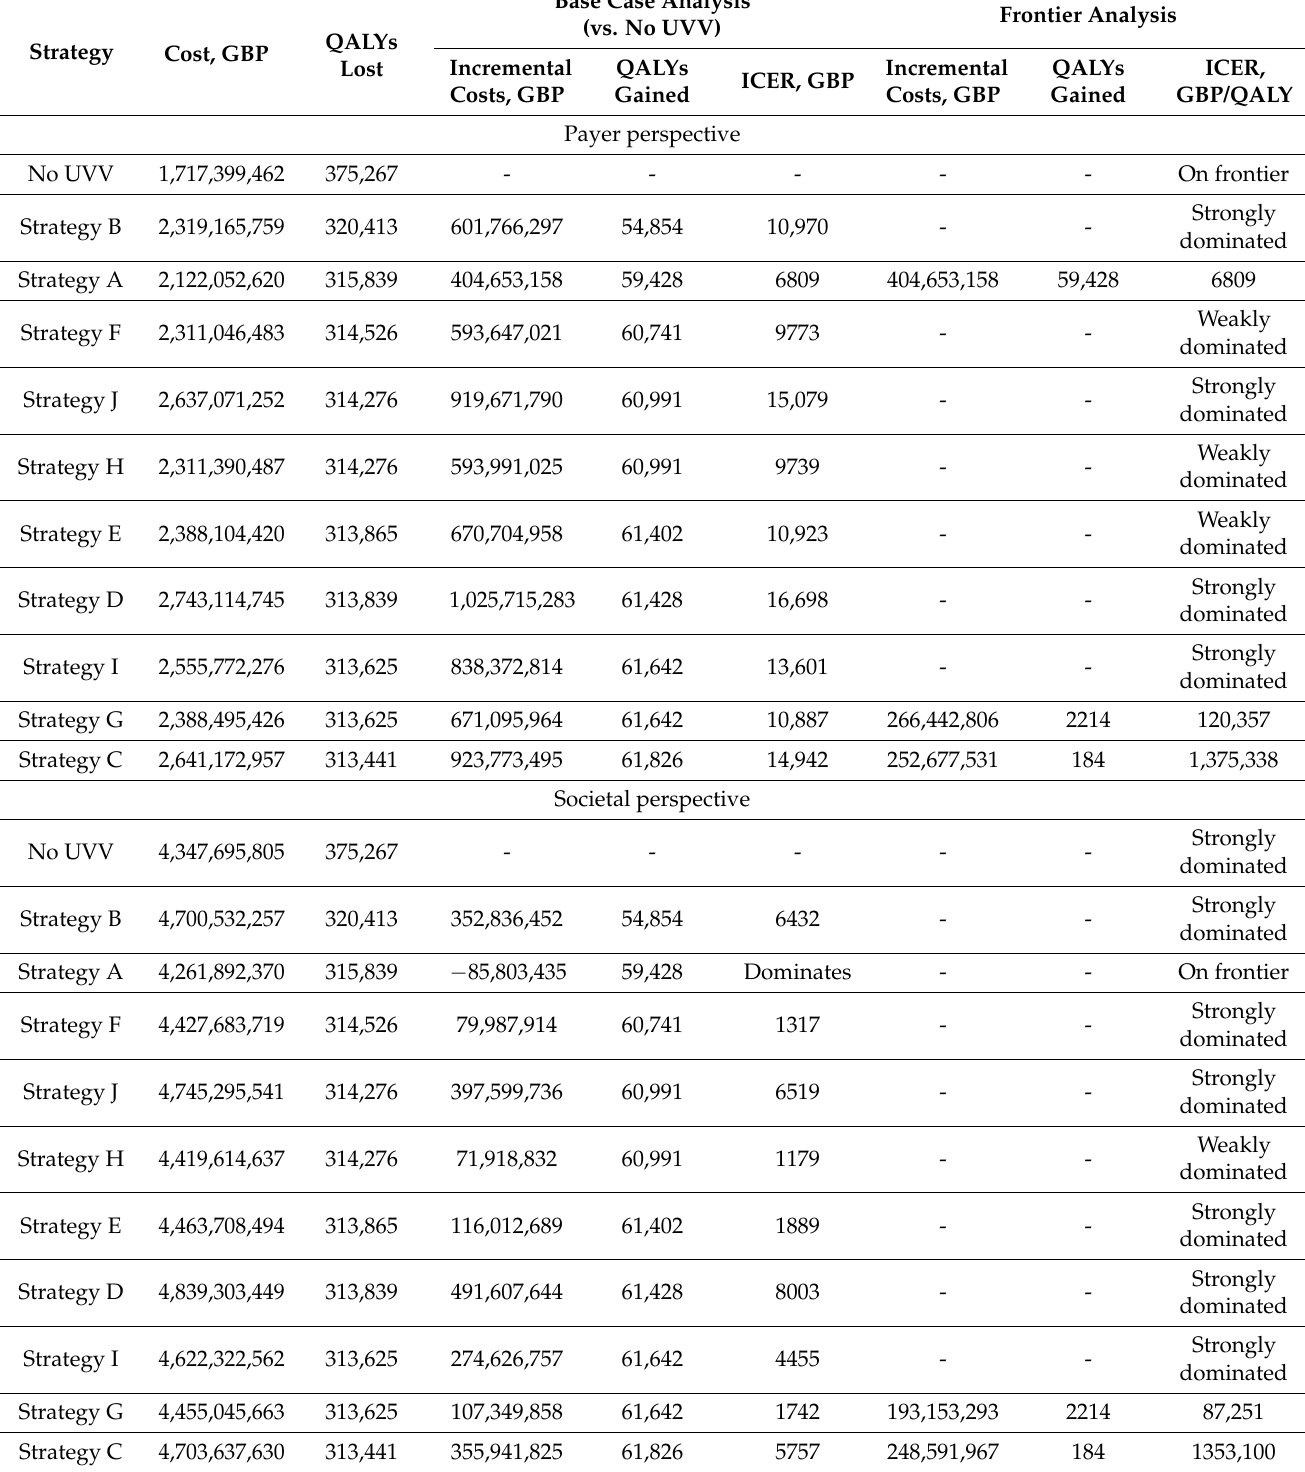
Table 2. Cost-effectiveness analysis for alternative UVV strategies from the payer and societal perspectives